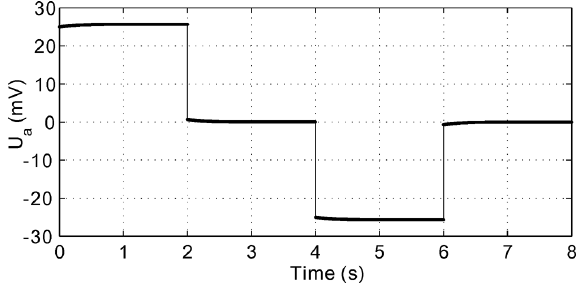
Figure 10. Time series in TDIP mode as captured by the